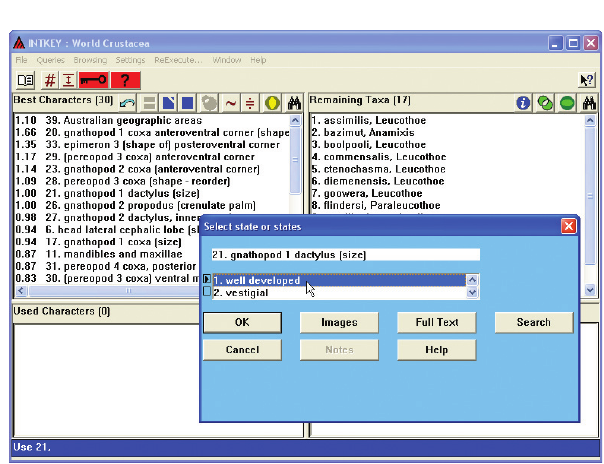
Figure 63. Interrogation mode.